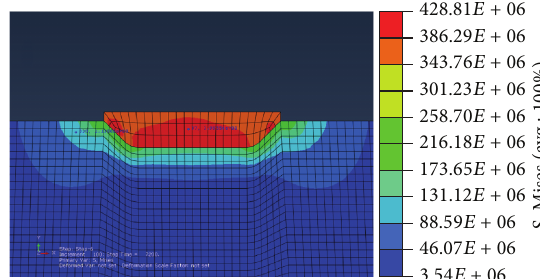
Figure 7: von Mises residual stress at the end of 3 thermal